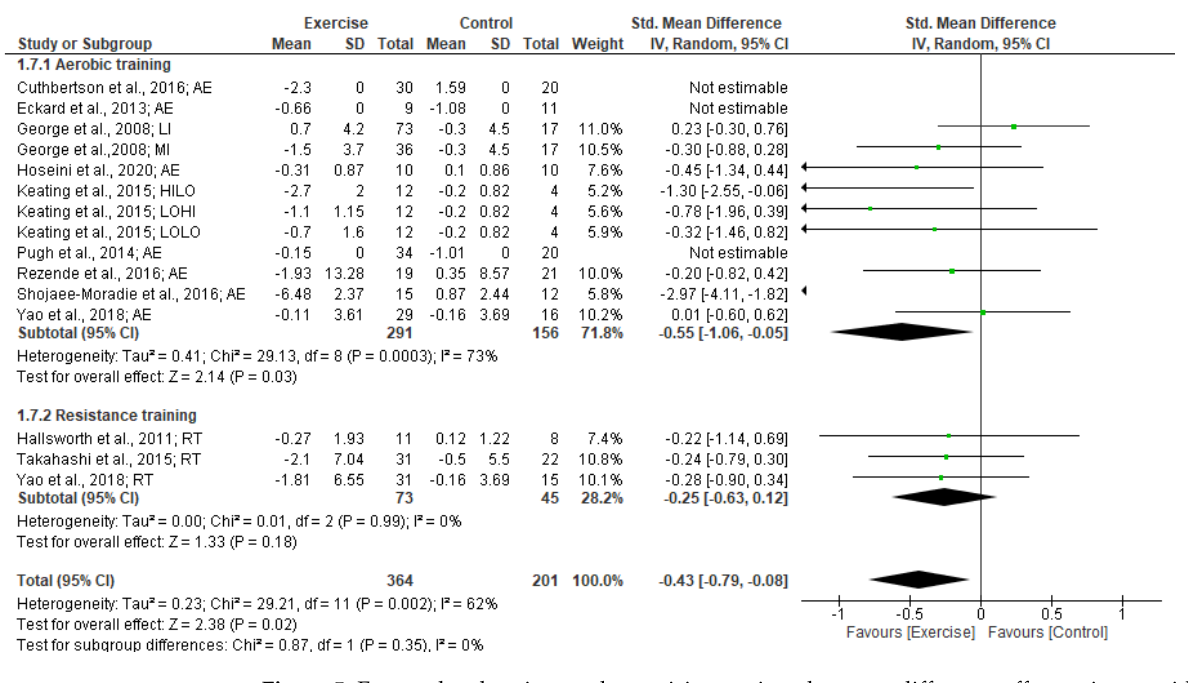
Figure 5. Forest plot showing study precision against the mean difference effect estimate with 95% confidence interval for insulin